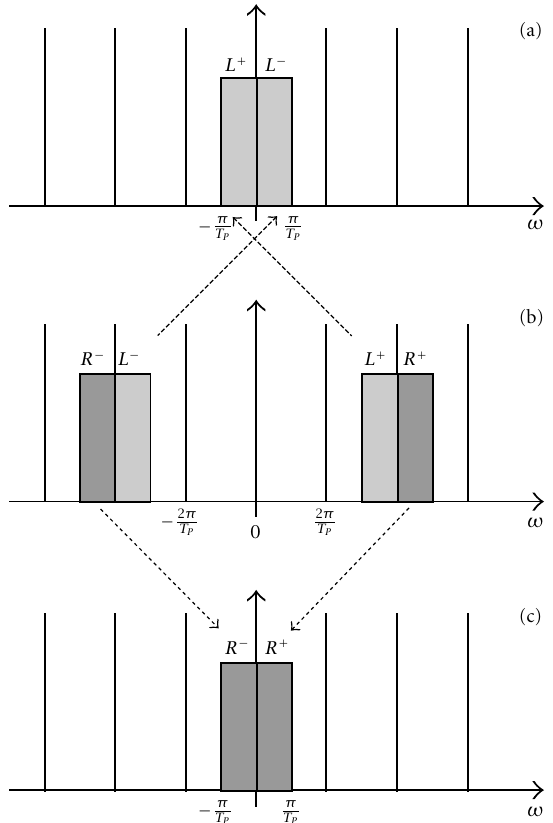
Figure 4: Baseband shift of harmonic sidebands: (b) sidebands of the 2nd harmonics; (a) demodulation of the left sidebands; (c) de- modulation of the right